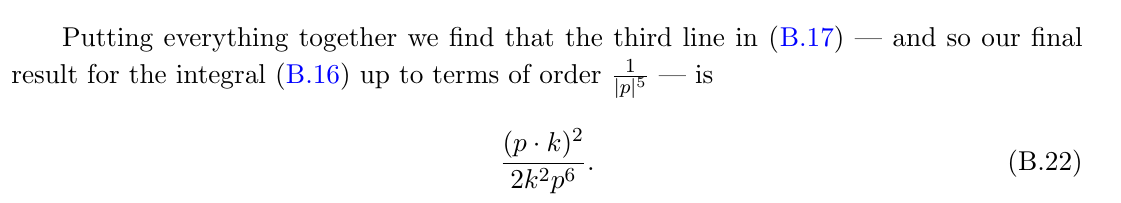
p + (cid:14); k; k (cid:14) (cid:0) (cid:0) (cid:0)